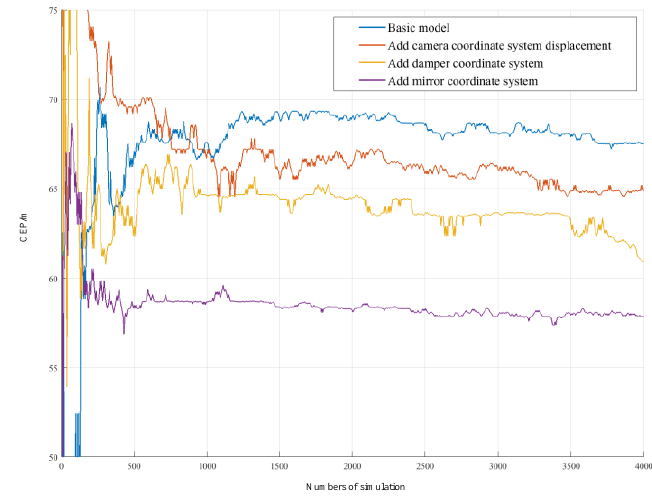
Figure 16. Schematic diagram of positioning accuracy